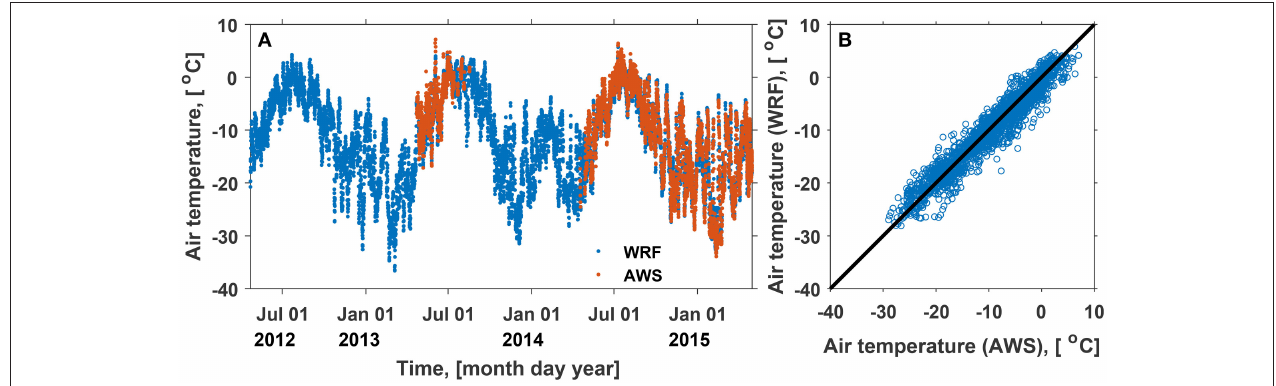
FIGURE 5 | Air temperature at the Lomonosovfonna ice field in April 2012–2015. (A) Values simulated using the regional climate model WRF (blue), AWS measurements (red). (B) Scatter plot illustrating the agreement between the simulated and measured values.